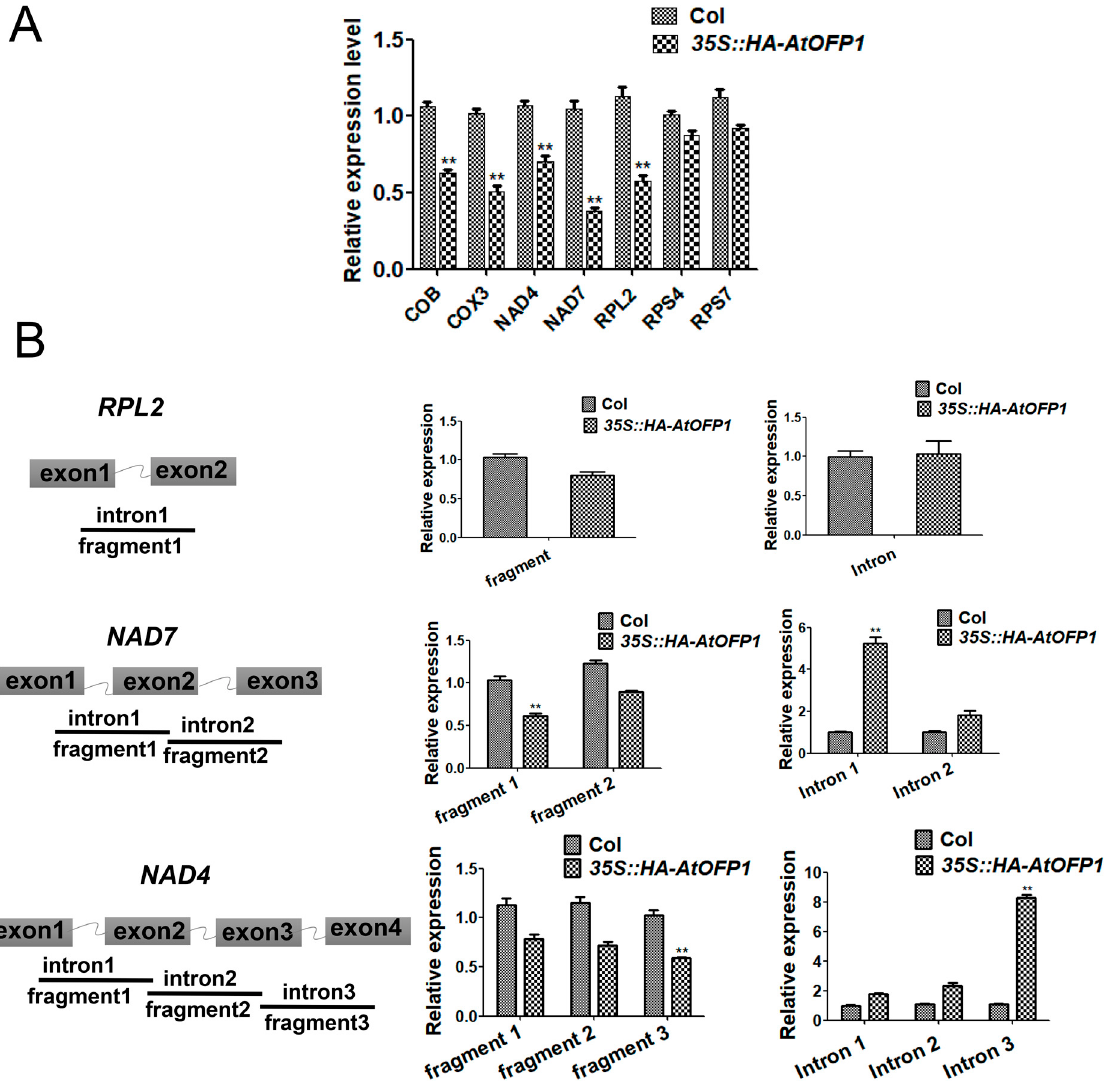
Figure 5. The regulation of AtOFP1 on NAD4 and NAD7 genes. ( A ) The expression pattern of mitochondria mature transcripts COB , COX3 , NAD4 , NAD7 , RPL2, RPS4 , and RPS7 by qRT-PCR. ( B ) Splicing efficiency analysis of mitochondrial membrane genes. The different fragments of the intron-containing NAD4 , NAD7 , and RPL2 transcripts were detected. Pairs of primers covering exons or introns was used for qRT-PCR. Three independent experiments were done with three biological repeats. Values are means ± SE from one experiment. ** p < 0.01.